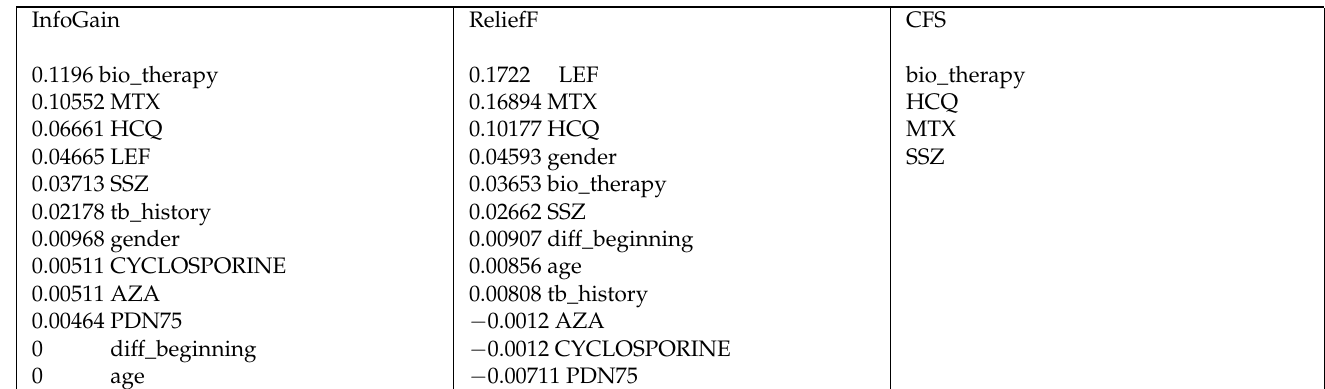
Table 15. The results of the attribute selection